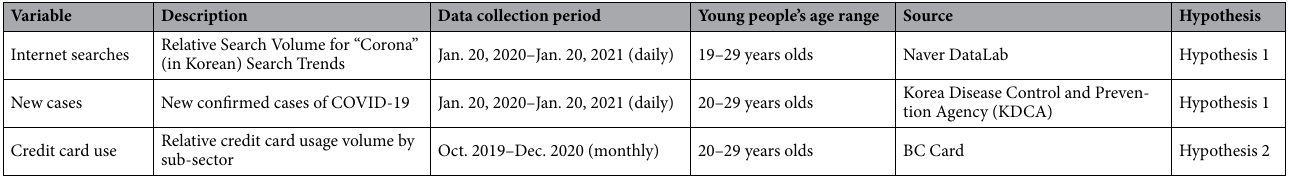
Table 1. Key research